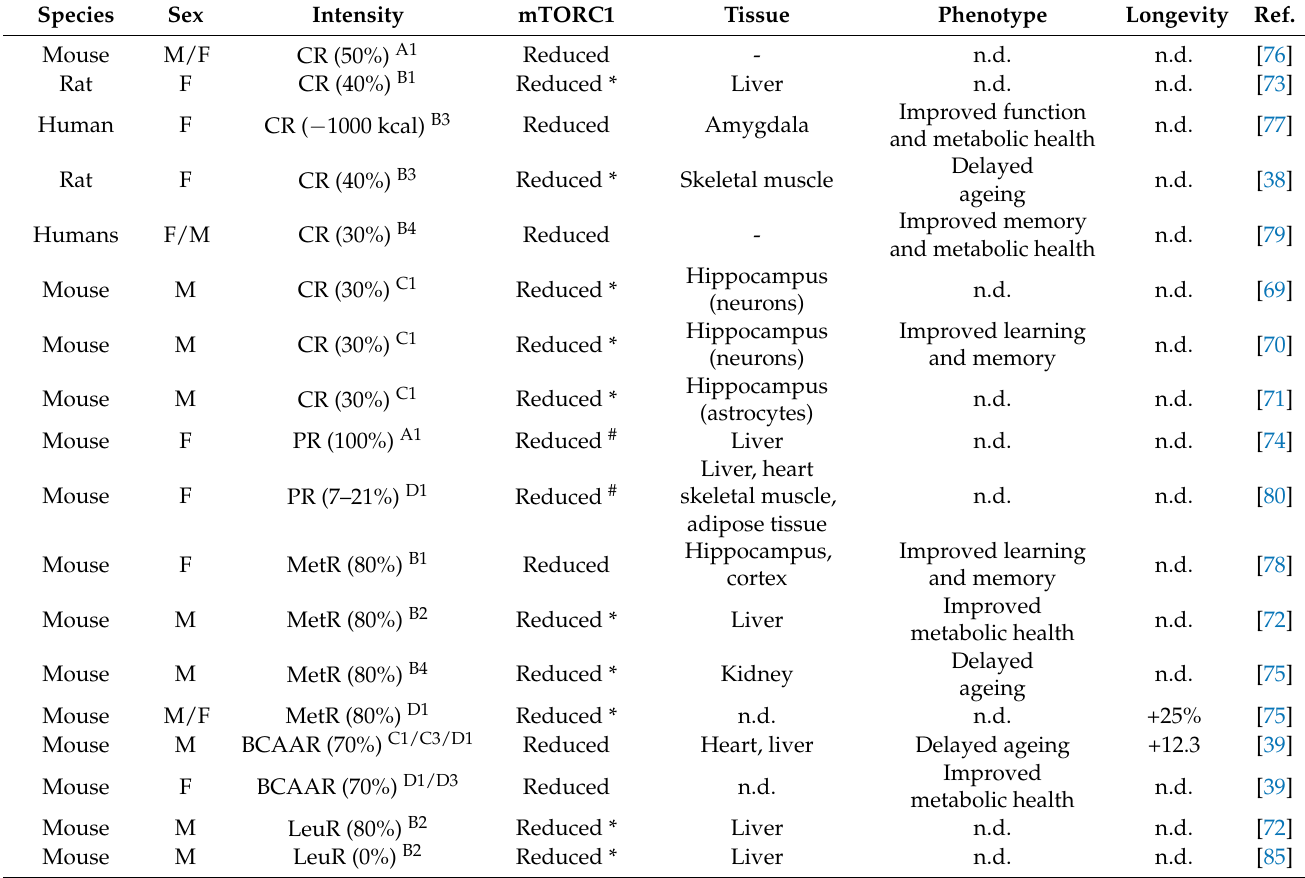
Table 5. mTOR regulation through nutritional interventions. Increased or reduced mTOR content can refer to transcript content, gene expression, protein content, protein phosphorylation or activity after insulin stimulation. Letters refer to: maximum longevity (ML), in years; dietary restriction (DR); protein restriction (PR); branched-chain amino acids restriction (BCAAR); leucine restriction (LeuR); methionine restriction (MetR); female (f); male (m); not determined (n.d.). Nutritional intervention (NI) duration is grouped according to different time periods: 1 very short-term (hours to days); 2 short- term (1 to 6 months); 3 long-term (more than 6 months); 4 lifetime (to natural death of the specimen). Beginning of the NI on is defined by superscript letters: A NI applied to young specimens; B NI applied to adult specimens; C NI applied to middle-aged specimens; D NI applied to old specimens. Symbols refer to: * Studies in which the expression, content or phosphorylation of mTORC1 itself were evaluated; # Studies in which mTORC1 itself wasn’t evaluated, but its upstream or downstream effectors